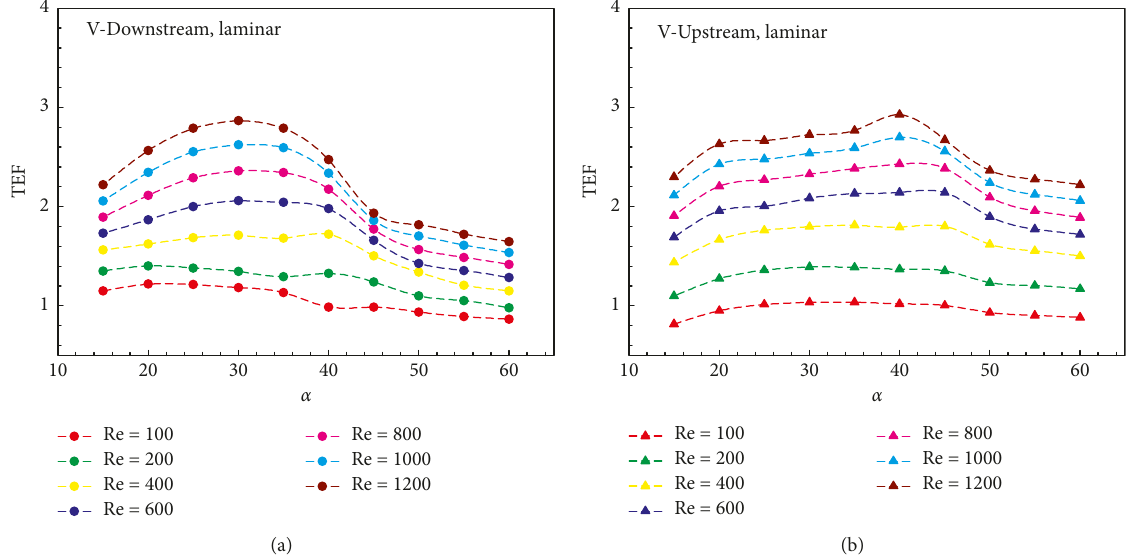
Figure 14: Relations of the TEF with α for the heat exchanger tube inserted with the V-wavy surface for (a) V-Downstream and (b) V- Upstream at the laminar